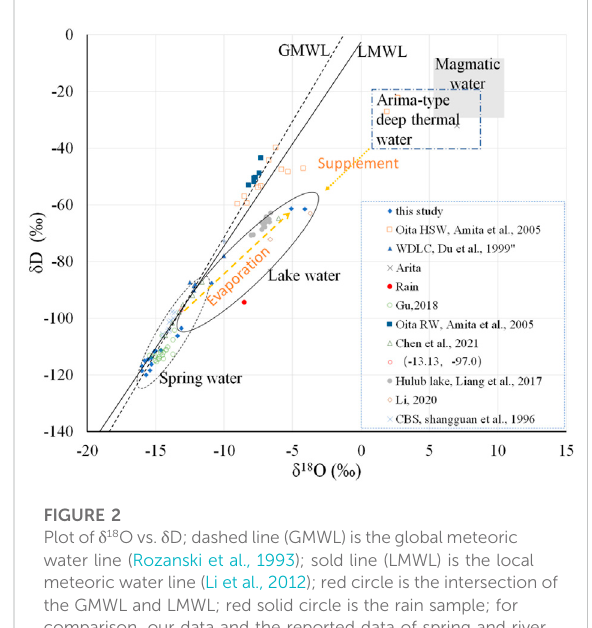
FIGURE 2 Plot of δ 18 O vs. δ D; dashedline (GMWL)is theglobal meteoric water line (Rozanski et al., 1993); sold line (LMWL) is the local meteoric water line (Li et al., 2012); red circle is the intersection of the GMWL and LMWL; red solid circle is the rain sample; for comparison, our data and the reported data of spring and river waters in the AVR (Gu et al., 2017; Li, 2020; Chen et al., 2021), Oita HSW and Oita RW - hot spring water and river water in Oita Plain and Arita - deep geothermal fl uid in Japan (Amita et al., 2005), WDLC - spring water in the Wudalianchi volcanic area (Du et